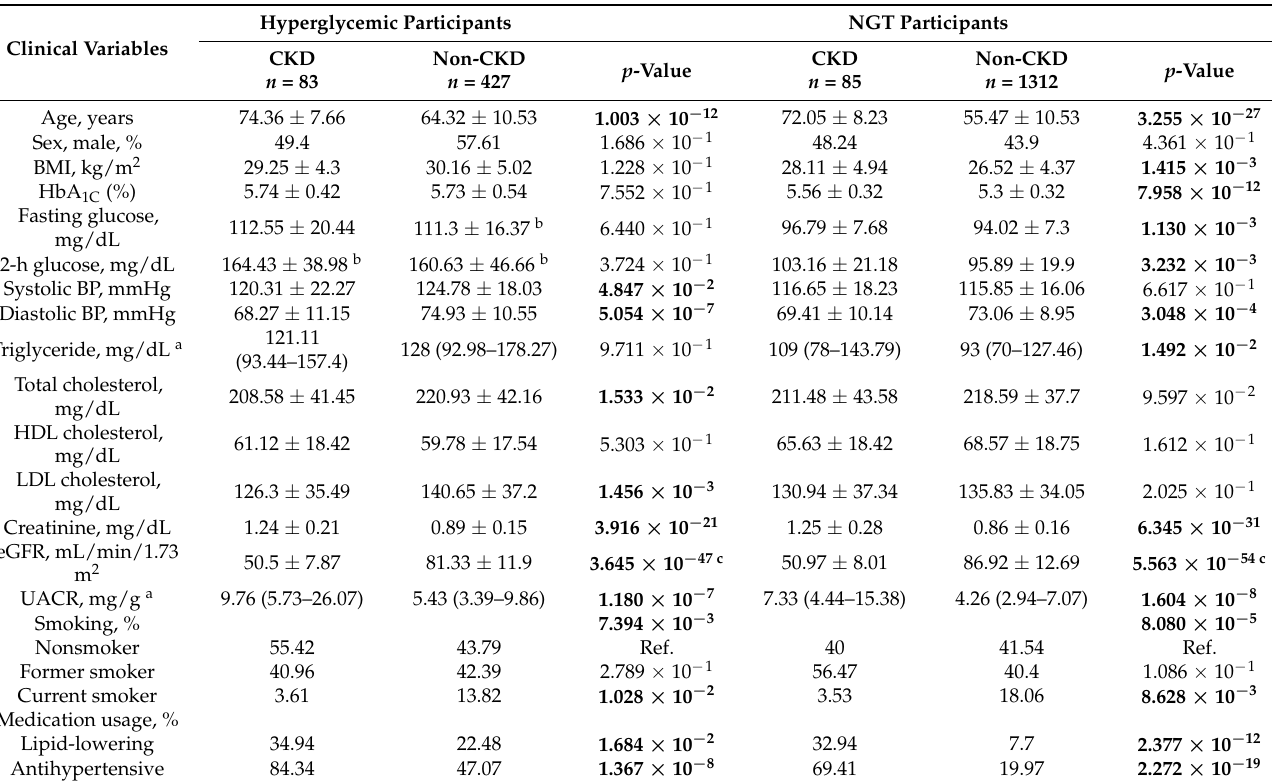
Table 1. Characteristics of the KORA FF4 participants according to their hyperglycemic status. Mean ± standard deviation is provided for quantitative variables if not indicated otherwise. p -values express the difference between CKD cases and non-CKD controls in hyperglycemic and NGT participants, respectively. p -values were calculated by univariate logistic regression if not indicated otherwise. p -values shown in bold represent statistical significance at the 0.05 level. Abbreviations: CKD, chronic kidney disease; HbA 1C , glycated hemoglobin; HDL, high-density lipoprotein; LDL, low-density lipoprotein; NGT, normal glucose tolerance; 2-h glucose, 2-h post-load glucose; BP, blood pressure; eGFR, estimated glomerular filtration rate; UACR, urinary albumin-to-creatinine ratio.